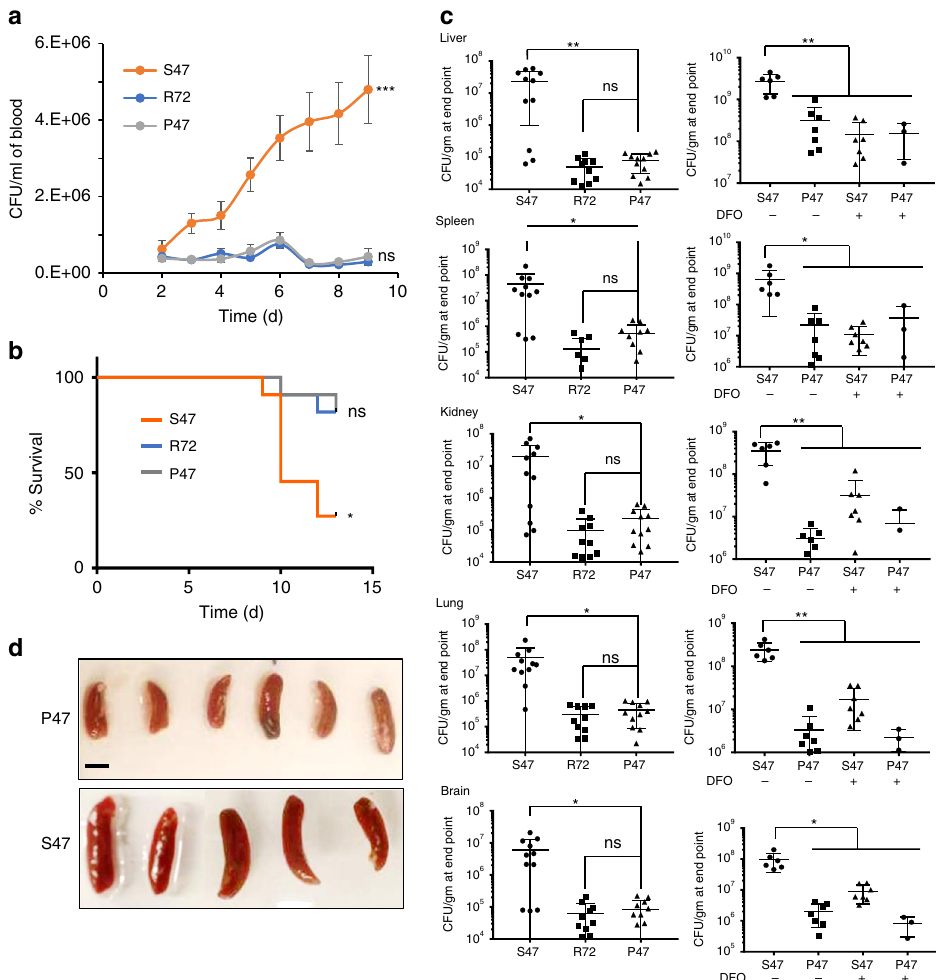
Fig. 3 S47 mice are more susceptible to Listeria infection than WT mice. a S47 P47 or R72 mice were infected with Lm and monitored daily from day 2 post infection by CFU and b survival ( n = 10 biological replicates). Error bars represent means ± s.e.m. *** P < 0.001, * P < 0.05, ns — not signi fi cant; by unpaired Student ’ s t test, relative to P47 mice. c Bacterial load in different organs at the time of death measured as CFU/gm ( n = 7 – 10 biological replicates with three technical replicates). Right panel compares changes in bacterial load in P47 & S47 mice following DFO treatment. Error bars represent means ± s.e.m. P < 0.01, * P < 0.05, ns — not signi fi cant; by unpaired Student ’ s t test, relative to P47 mice. d Spleens of P47 and S47 mice at 13 days post infection. Bar = 1 cm. Source data are provided as a Source Data fi